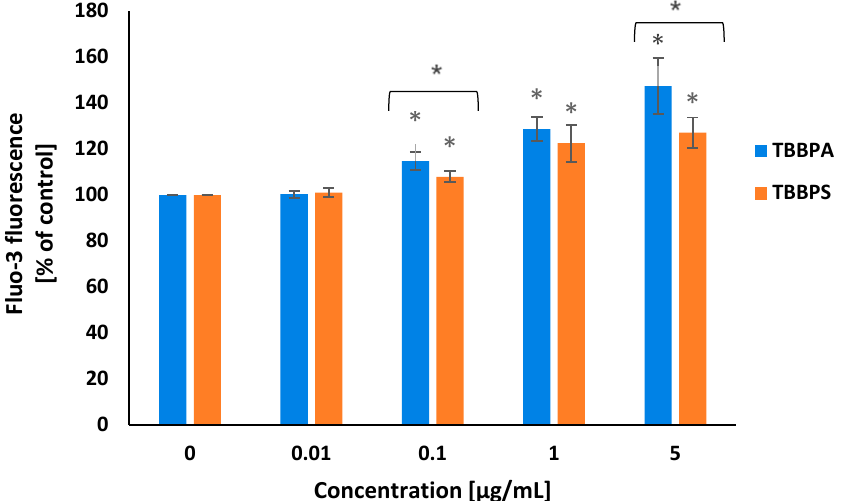
Figure 2. Alterations in cytosolic calcium ion level in human PBMCs treated with TBBPA and TBBPS in the range from 0.01 to 5 µg/mL (n = 4) for 24 h. Statistically different from negative control at * p < 0.05. Statistical analysis was conducted using one-way ANOVA and a posteriori Tukey test.